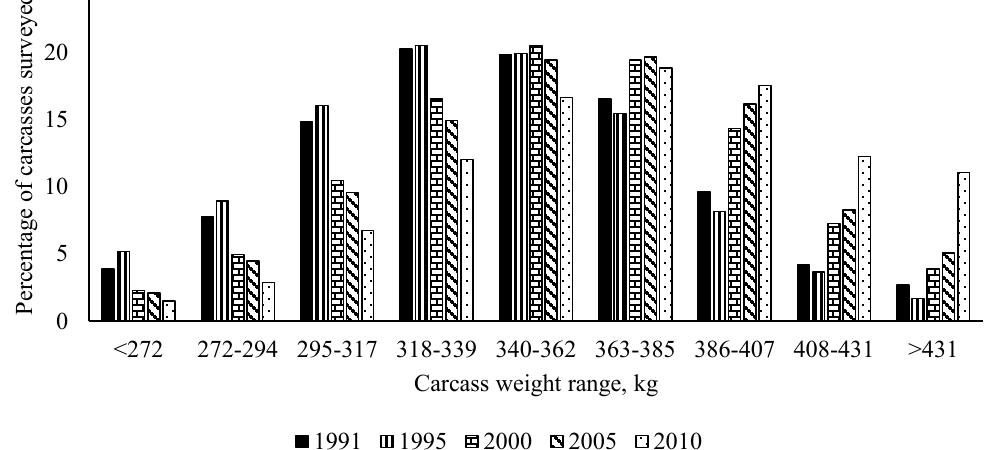
Figure 1. Distribution shift of carcass weights associated with the 5 National Beef Quality Audits. Adapted from Lorenzen et al [3], Boleman et al [4], McKenna et al [5], Garcia et al [6], and Moore et al [7].